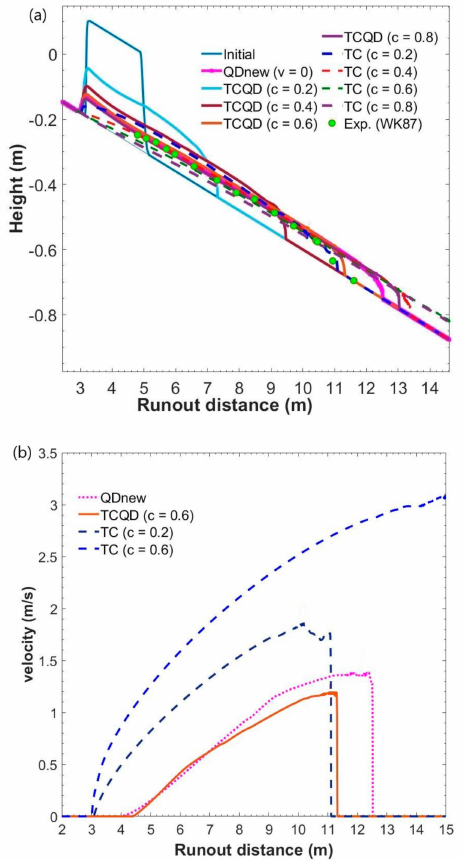
Figure 2. ( a ) Sensitivity result for different concentrations using TC and TCQD and comparison of debris-flow height with experimental and numerical data sets for case WK87 (“Exp.” data from Wright and Krone [34]). ( b ) Velocity profiles for QDnew, TC, and